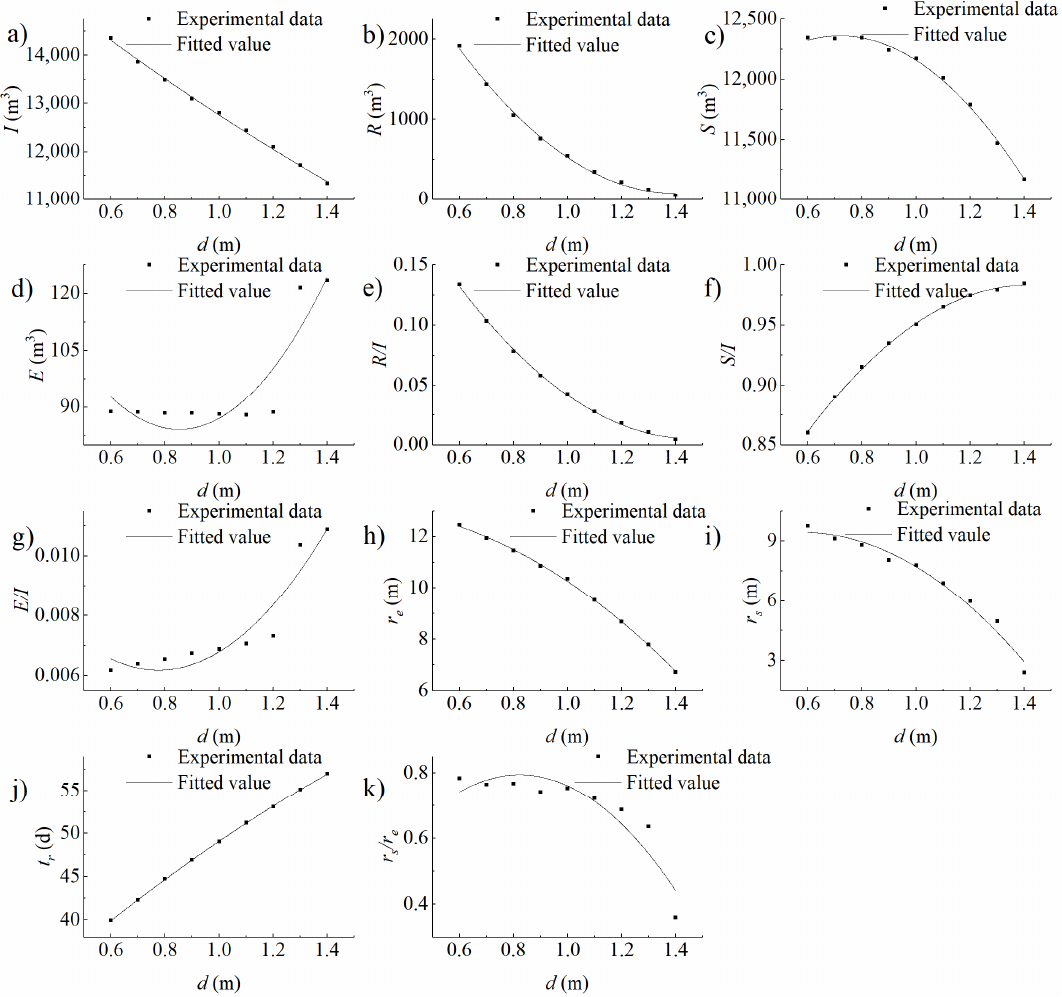
Figure 13. The variations with an increment in d when the depth is 5 m. (( a ) variation of I; ( b ) variation of R; ( c ) variation of S; ( d ) variation of E; ( e ) variation of R/I; ( f ) variation of S/I; ( g ) variation of E/I; ( h ) variation of r e ; ( i ) variation of r s ; ( j ) variation of t r ; ( k ) variation of r s /r e .).